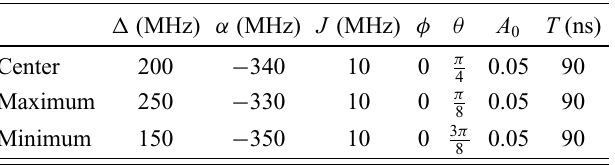
TABLE IV. The parameter space for the optimization of the two-qubit CR gate as given in Eq. (38). Compared to the simula- tion of the CNOT gate, given in Table III, the range of the target- control frequency detuning (cid:7) is reduced but the continuous parameter θ is also considered.